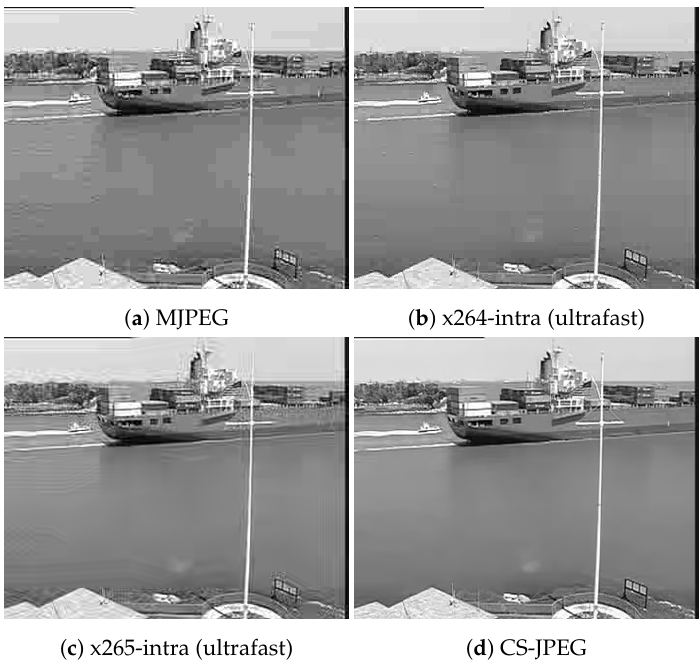
Figure 11. Frame with index 150 at R T = 600 kbps for ‘Container’.